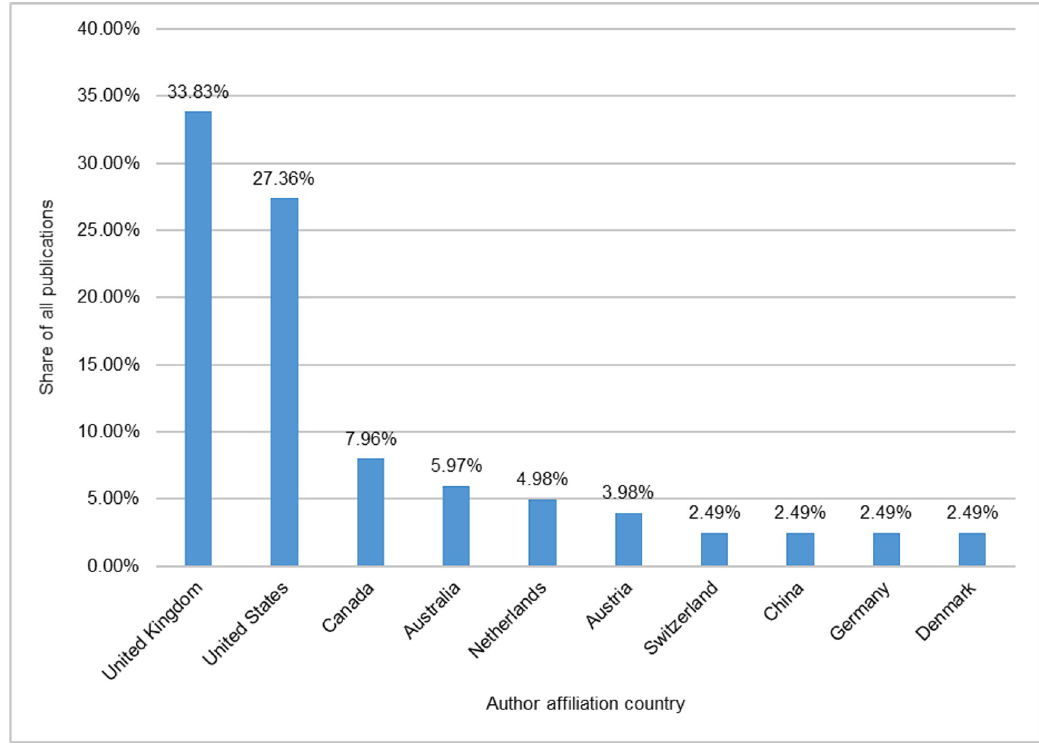
Fig 4. Country affiliations of authors in the project sample who published in PUS and SC , as captured by the Web of Science (N = 206).